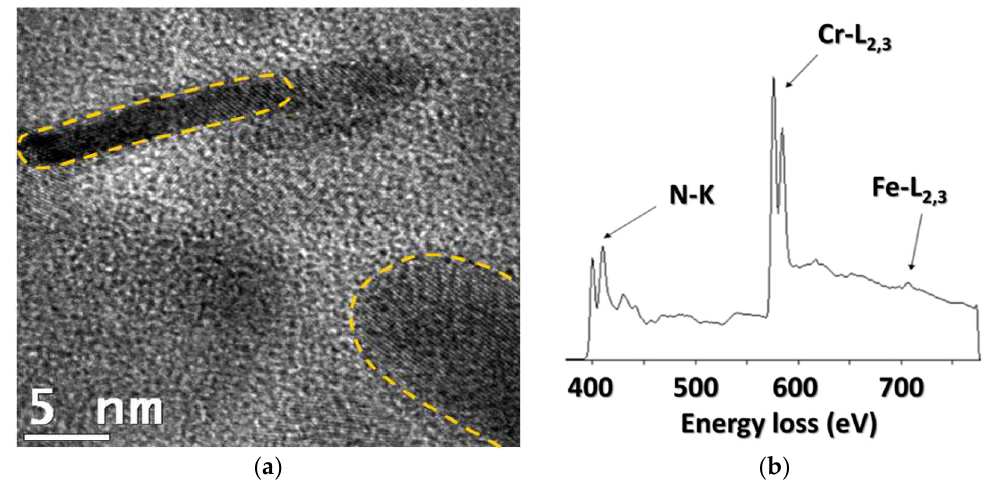
Figure 8. ( a ) TEM micrograph of nitride replicas on carbon film and ( b ) corresponding electron energy loss spectrometry (EELS) spectrum indicating the presence of Fe in Cr-rich nitrides.